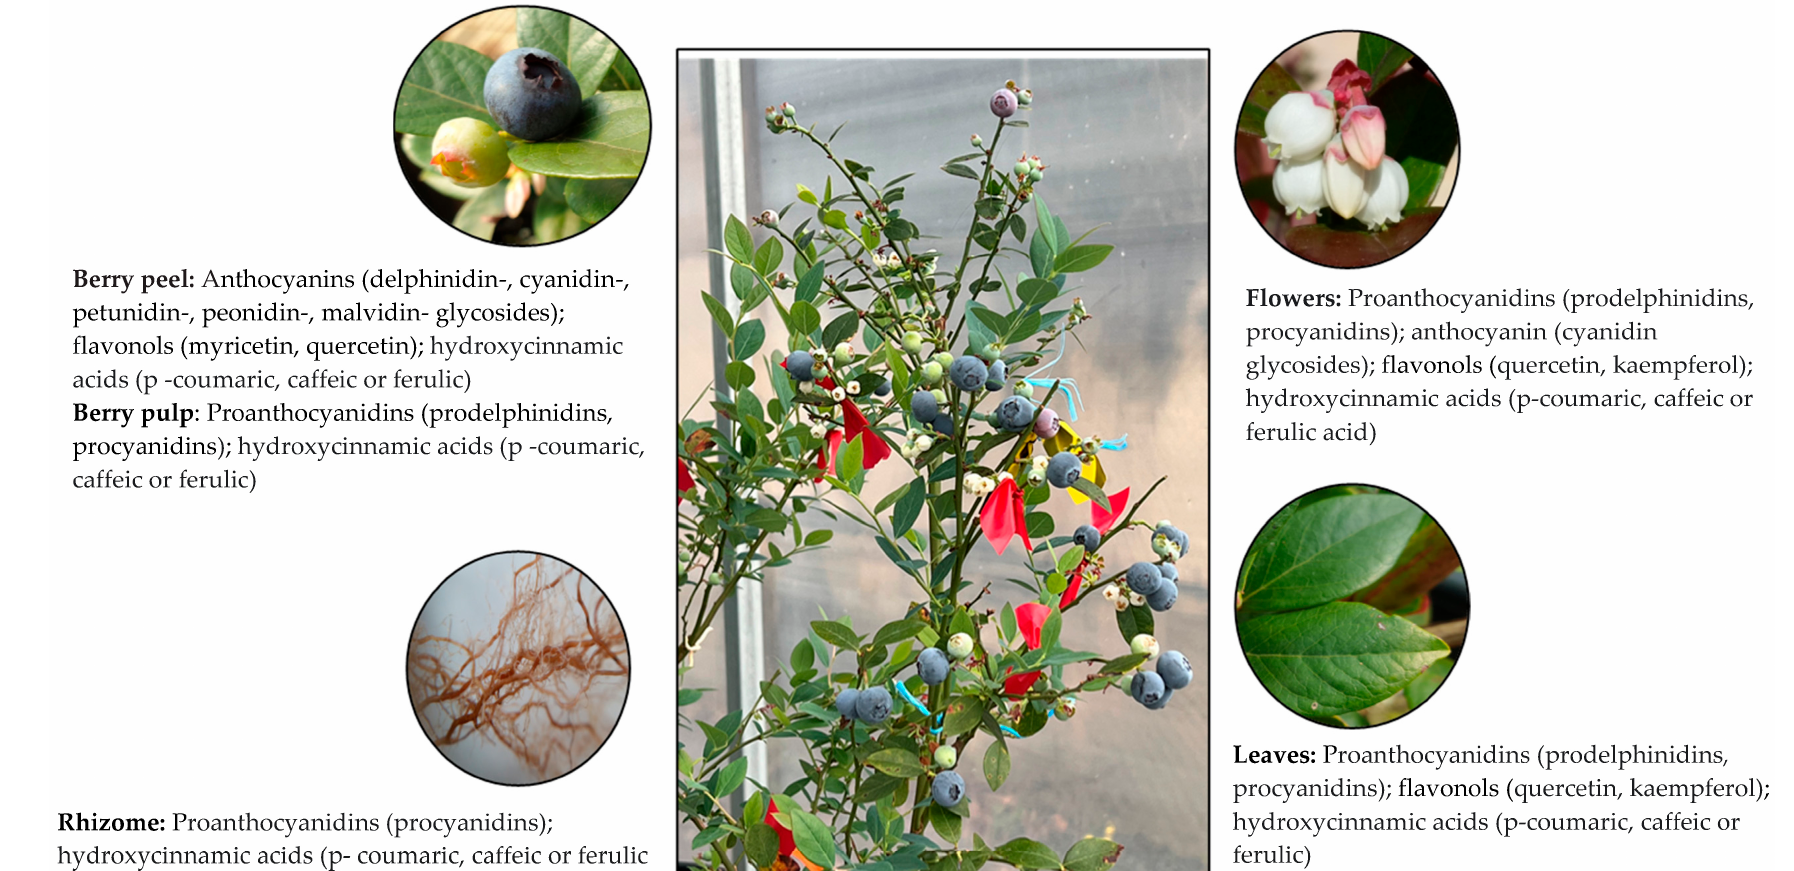
Figure 1. Bioactive compounds present in blueberry plant parts (text based mainly on values reported by [42]).